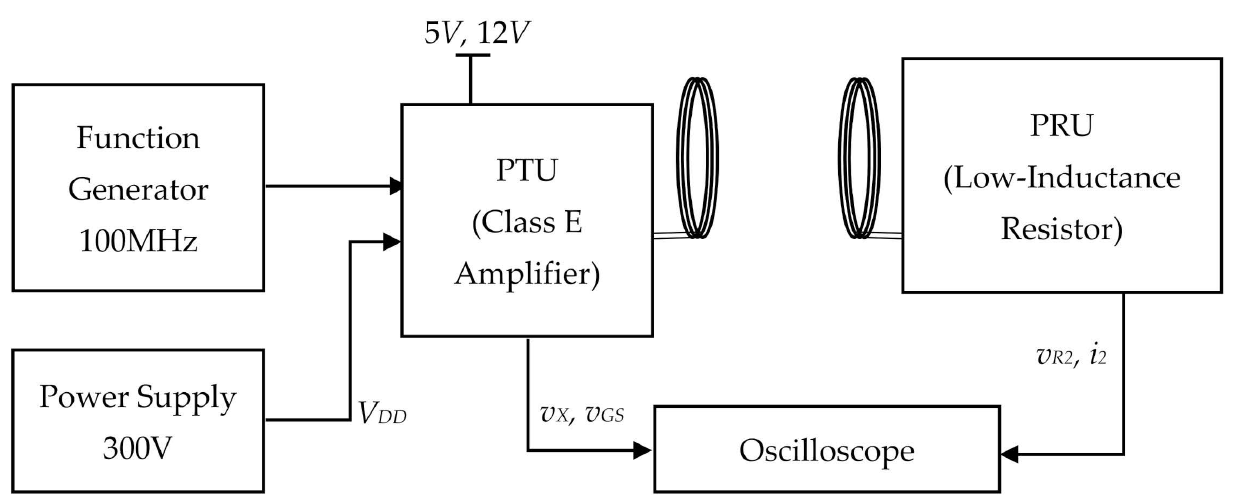
Figure 9. Experiment layout with a single PTU transferring power to multiple PRUs. The PTU antenna is hidden behind the painting shown in Figure